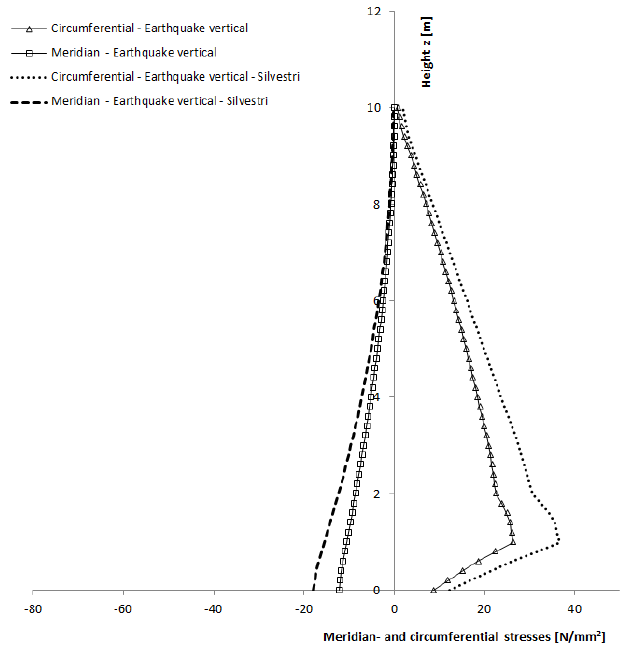
Figure 11. Circumferential and axial stresses due to vertical seismic excitation.